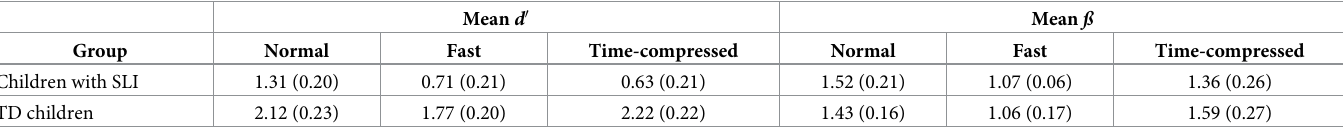
Table 2. Mean d 0 and β as a function of Group and Speech